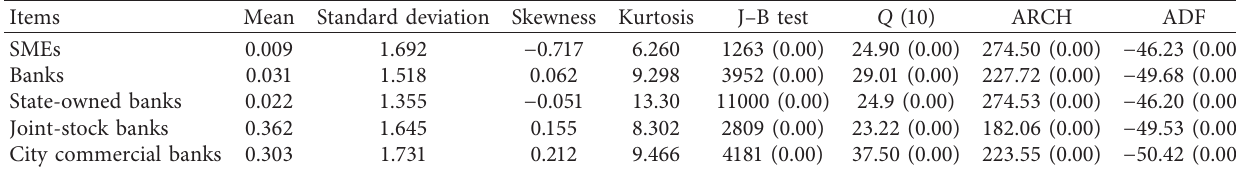
Table 1: Descriptive statistics.